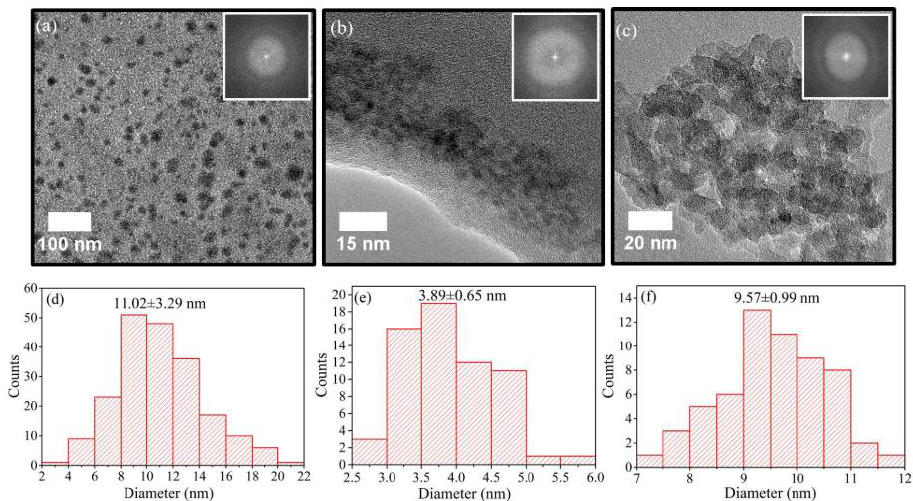
Figure 35. TEM images of soybean-derived NPs: ( a ) HTC-CDs, ( b ) annealed-CDs, ( c ) LA-CDs, ( d – f ) the size distributions, respectively. the size distributions, respectively. [118]